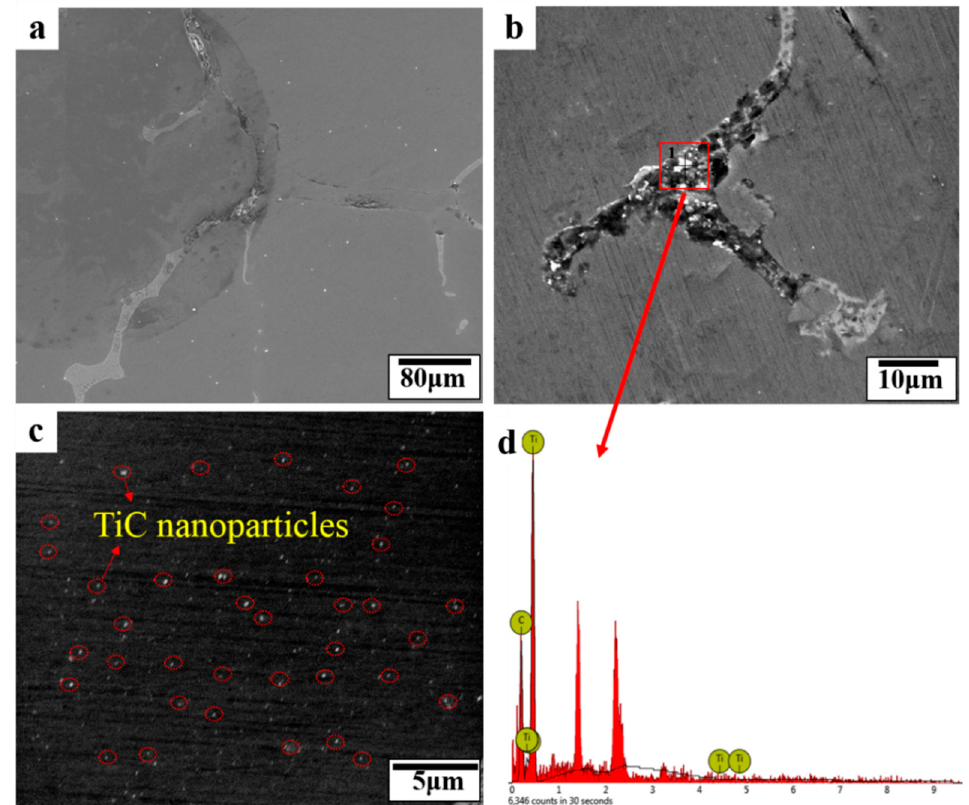
Figure 4. SEM micrographs of ( a ) aggregated TiC nanoparticles along the grain boundaries of 0.9 wt.% Table 2219. nanocomposite; ( b ) magnification SEM micrograph of the microstructure; ( c ) TiC nanoparticles dispersed in the matrix; ( d ) Energy Dispersive Spectrometer (EDS) results corresponding to the phase.